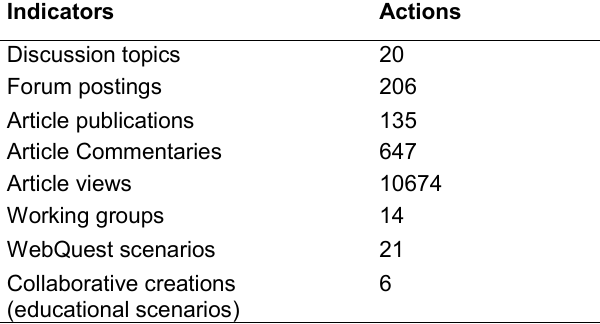
Figure 2. Students’ activity distribution chart